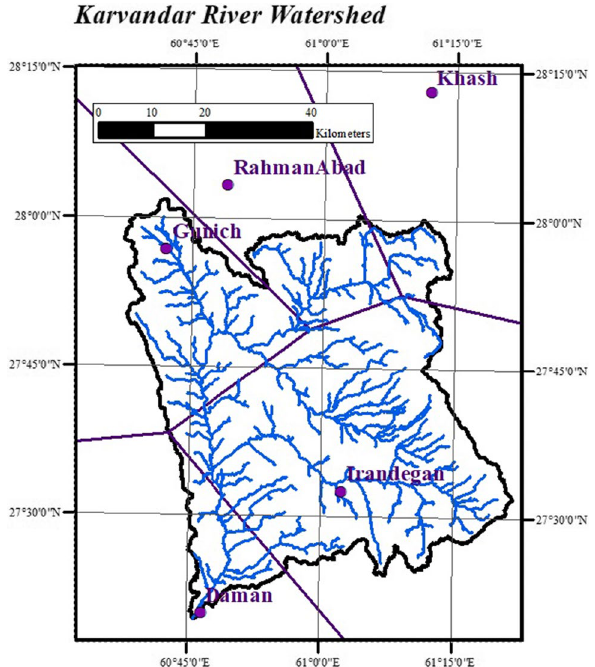
Fig. 9 Location of rain gauge stations and Thiessen polygons on physiographic model of Karvandar River watershed